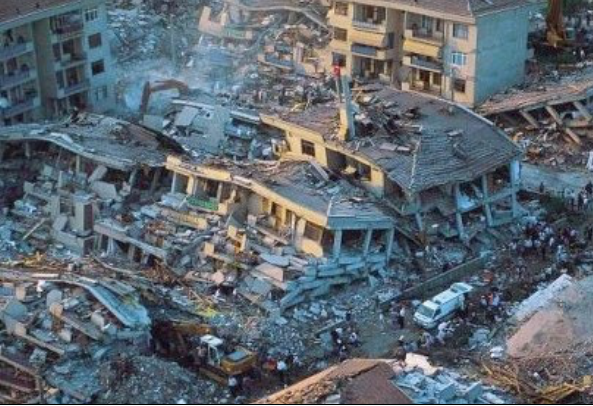
Table 1. Earthquakes in Turkey since 1990 Source: URL3, 2013